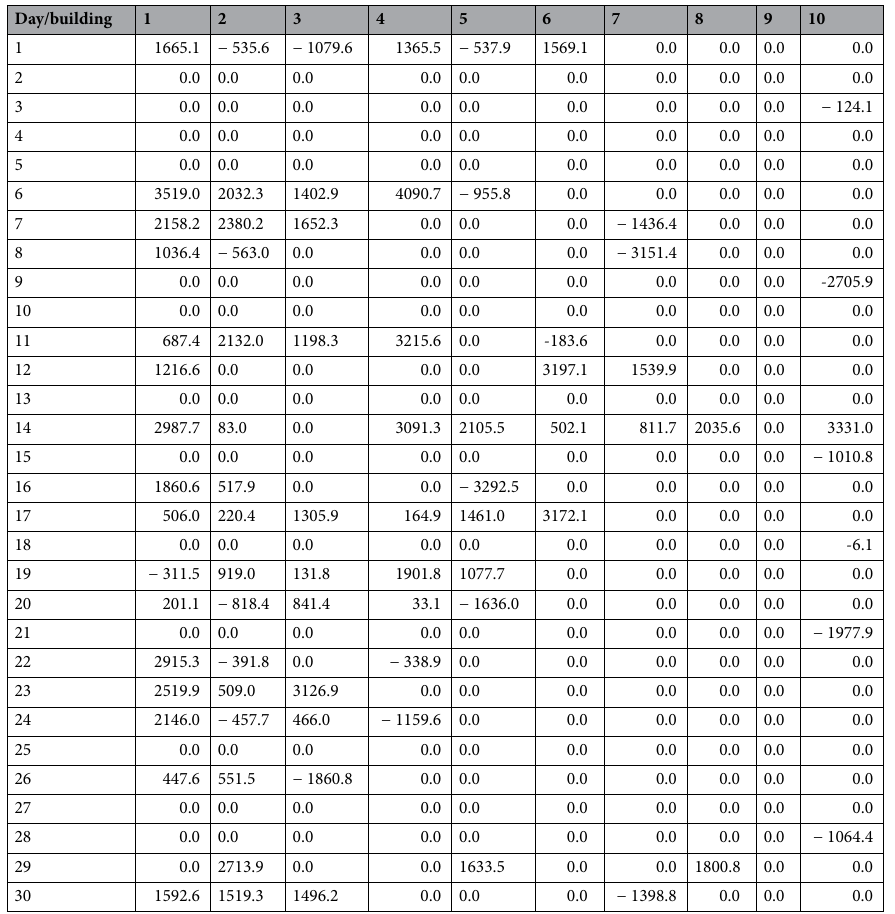
Table 3. The surplus and shortage of energy of each building throughout the month.